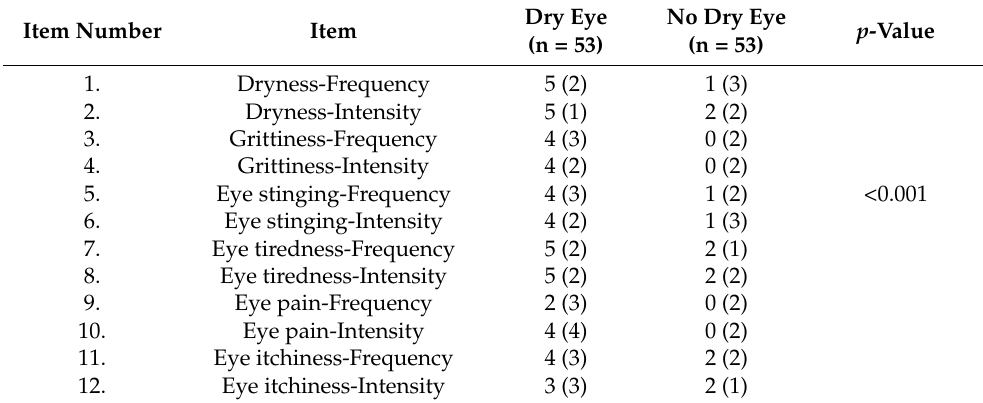
Table 6. Median (IQR) Scores for 12 Questions Awarded by Respondents with and without Dry Eye.